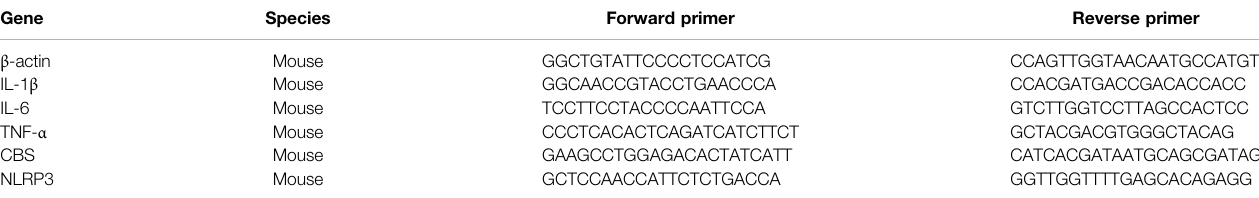
TABLE 1 | Primer pairs used for qRT-PCR. Gene